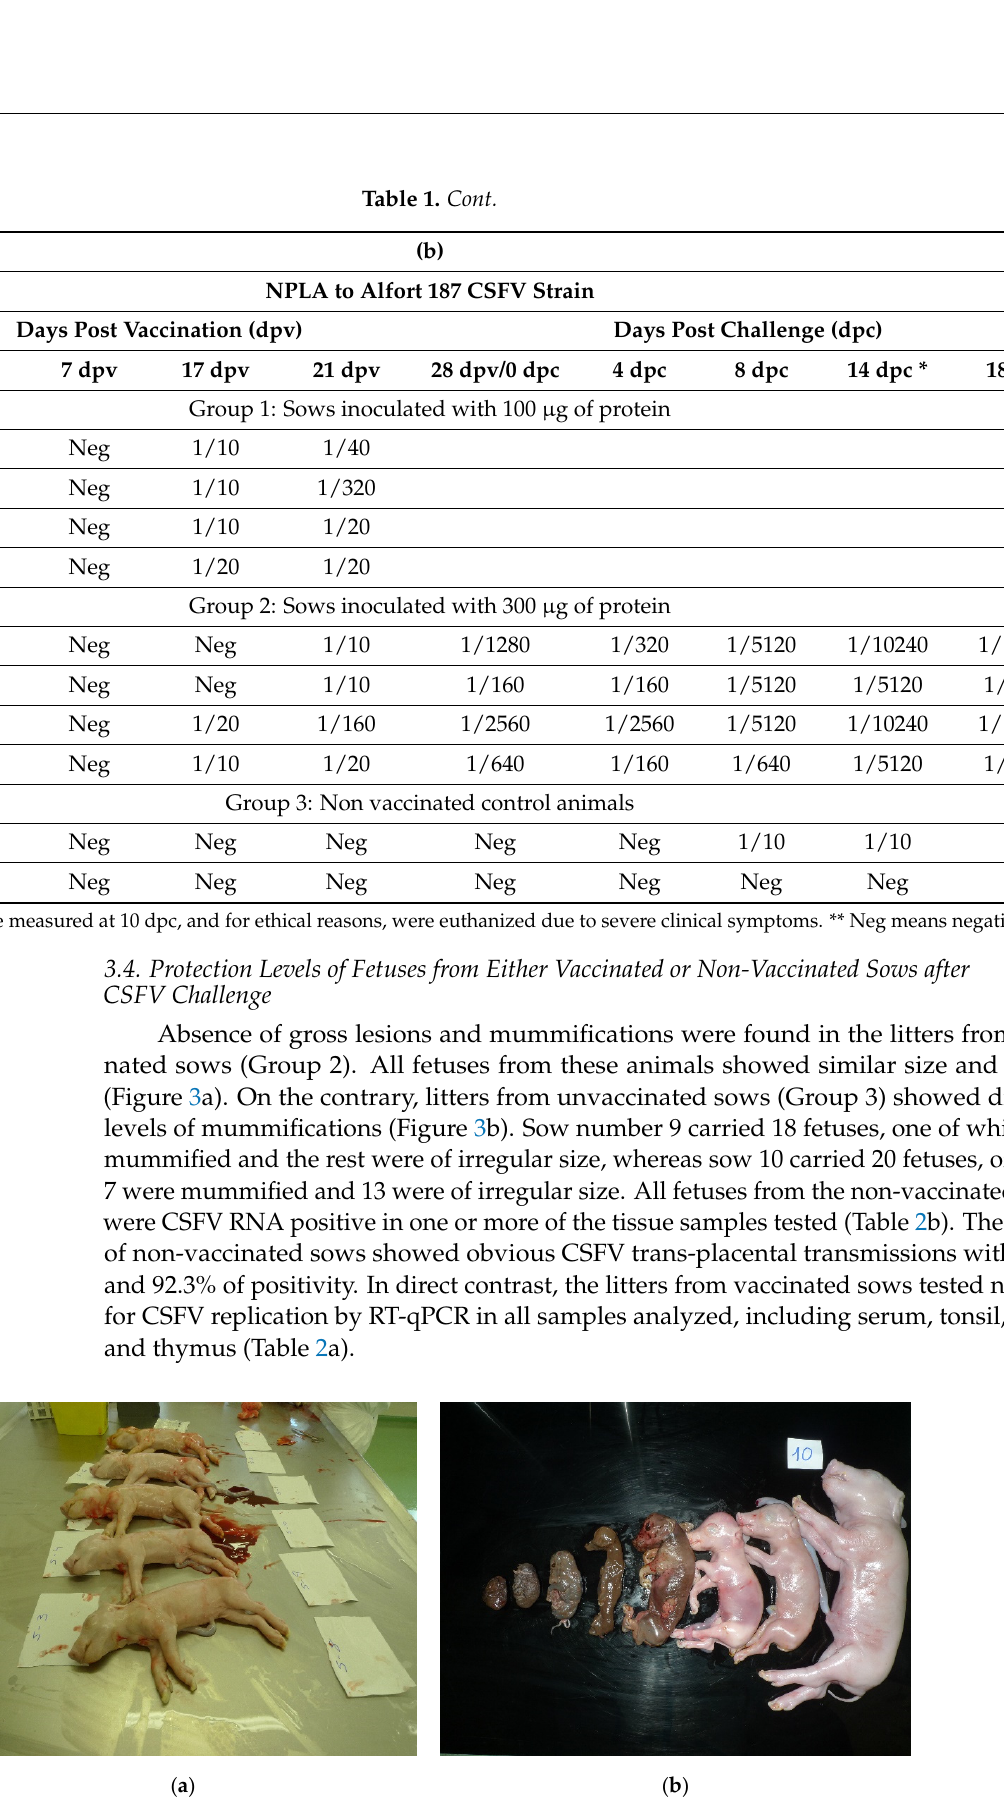
Figure 3. Representative fetuses of sows challenged with highly virulent CSFV Margarita strain. ( a ) Litters of sows vac- cinated with E2-Bioapp (300 μ g/dose) were observed healthy and uniform in size. ( b ) Fetuses from the unvaccinated sows were mummified and the remaining showed uneven size. Table 2. Detection of CSFV RNA in tissue samples of fetuses from either vaccinated or non-vaccinated sows after chal- lenge: ( a ) Tissue samples of fetuses from vaccinated sows, ( b ) Tissue samples of fetuses from non-vaccinated sows. ( a )